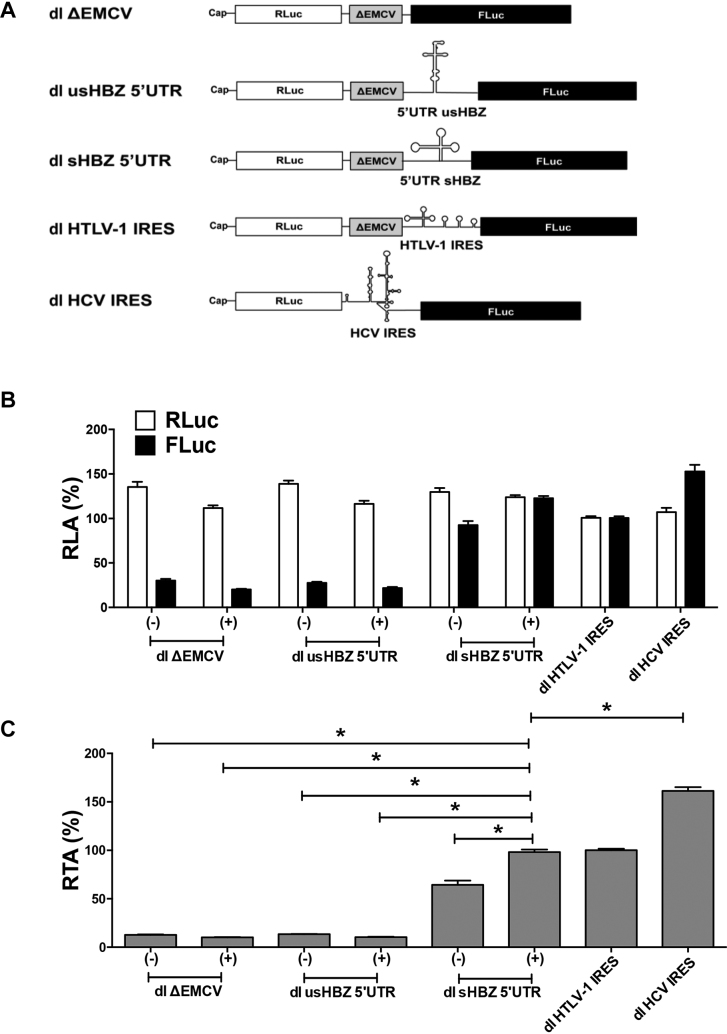
The sHBZ 5′UTR can initiate translation in the context of a bicistronic mRNA in vitro. (A) Schematic representation of the dual luciferase (dl) RNAs used. RNAs were in vitro transcribed with a 5′cap structure. The first cistron, RLuc is translated cap-dependently while translation of the second cistron, FLuc is dependent on the presence of an IRES in the intragenic region. The ΔEMCV element serves as a highly structured region and is expected to prevent readthrough or reinitiation following translation of RLuc. (B and C) In vitro transcribed capped dl usHBZ 5′UTR, dl sHBZ 5′UTR or dl ΔEMCV RNAs were translated in RRL (−) or in salt-optimized RRL (+) (Supplementary Figure S2). The control dl HTLV-1 IRES and dl HCV IRES dl RNAs RRL optimized for each IRES activity as described in ‘Materials and Methods’ section. RLA (B) or relative translation activity (RTA) (C) are reported relative to the capped dl HTLV-1 IRES activity, which was set to 100%. Values are the mean (+/− SEM) for at least four independent experiments, each performed in duplicate. RTA corresponds to the FLuc/RLuc ratio that is used as an index of IRES activity. Statistical analysis was performed by an ANOVA test followed by a Dunnett’s multiple test comparison (*P < 0.05).